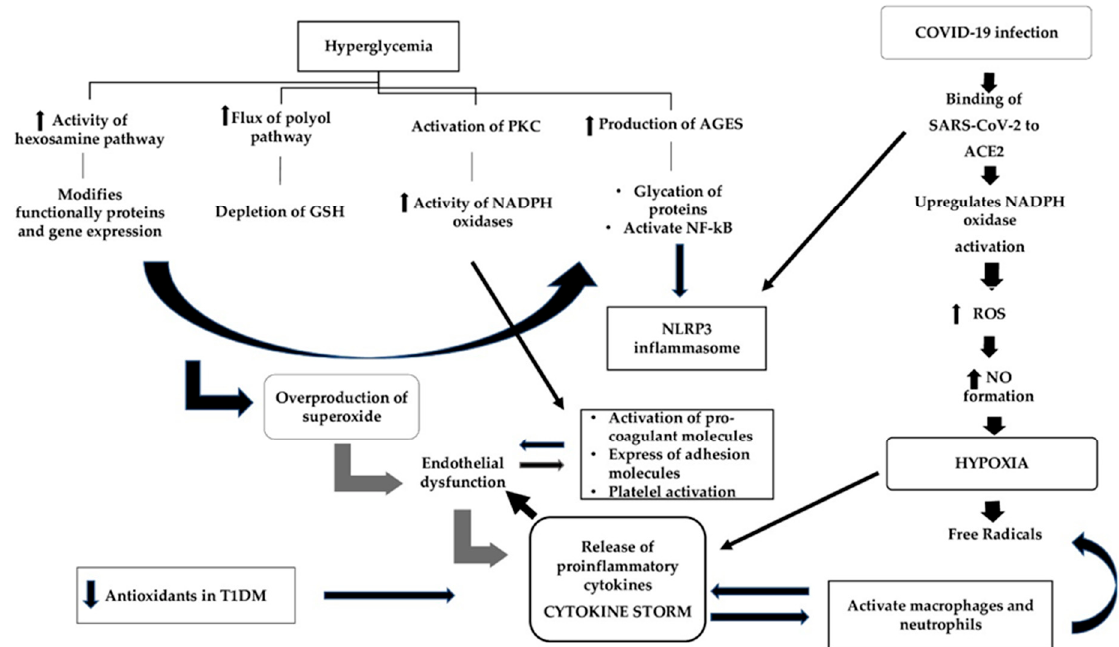
Figure 2. The mechanisms of oxidative stress leading to adverse clinical outcomes during COVID-19 infection in patients with type 1 diabetes mellitus. In T1DM, hyperglycemia is a potent mediator of oxidative stress through four different pathways whose accumulative effect is the overproduction of superoxide, which leads to endothelial dysfunction and the subsequent release of pro-inflammatory cytokines. The destroyed endothelial cells release pro-coagulant molecules and express adhesion molecules. Simultaneously, hyperglycemia through the activation of the PKC pathway increases the expression of adhesion molecules, contributing additionally to endothelial dysfunction, and this leads to platelet activation and aggregation. During COVID-19 infection, the binding of SARS-CoV-2 to angiotensin-converting enzyme 2 (ACE2) results in the increased production of reactive oxygen species (ROS), which in turn increases NO formation and leads to cytopathic hypoxia. Hypoxia via the formation of free radicals upregulates the release of pro ‐ inflammatory cytokines, which promotes endothelial derangement and contributes to pro ‐ coagulability. Additionally, the upregulation of pro ‐ inflammatory cytokines, in a vicious cycle, activate macrophages and neutrophils to produce more free radicals. Neutrophils have been recognized as pivotal mediators of severe COVID-19 disease by triggering the production of pro-inflammatory cytokines and maintaining the inflammatory state in the lungs. AGEs: advanced glycation end products; GSH: glutathione; NADPH: nicotinamide adenine dinucleotide phosphate; NF-kB: nuclear factor-kB; NLRP3: NOD-like receptor family pyrin domain ‐ containing 3 ; NO: nitric oxide; PKC: protein kinase C; ROS: reactive oxygen species.